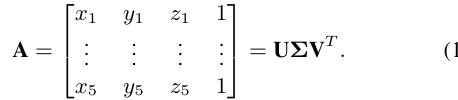
Figure 3. Point cloud colored according to MSE values of the point inclinations. Shed dormer (top) and gabled dormer (bot- tom).